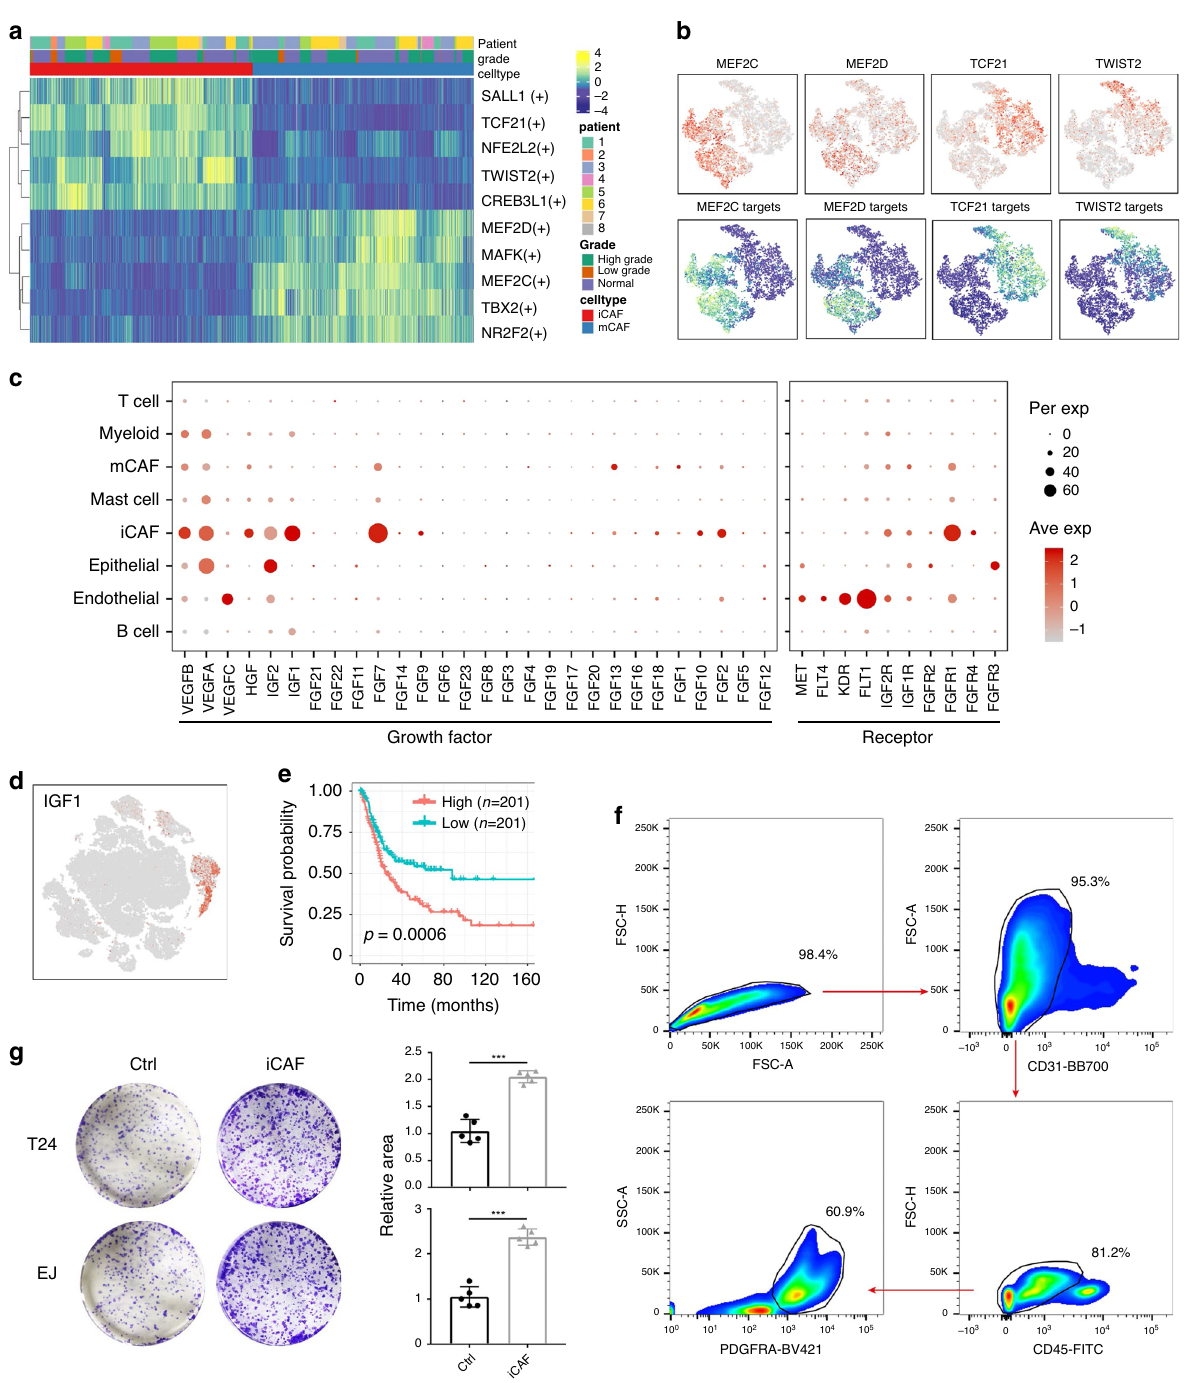
Fig. 4 iCAFs promote proliferation of cancer cells. a Heatmap of the area under the curve (AUC) scores of TF motifs estimated per cell by SCENIC. Shown are top fi ve differentially activated motifs in iCAFs and mCAFs, respectively. b tSNE plots of the expression levels of TFs (up) and AUC scores (down). c Dot plot shows the expression level of growth factors across cell types. iCAFs are the major producer of growth factors. d tSNE plot shown the expression level of IGF1. IGF1 is secreted almost only by iCAFs. e High level IGF1 represents poor overall survival in TCGA BLCA cohort. P value was calculated with log-rank test. f FACS sorting strategy of iCAFs. g Co-culture and colony formation experiment showed that iCAFs have pro-proliferation property in vitro ( n = 5). Error bar: mean value ± sd. P values were determined by two-side Student ’ s t test. *** p <